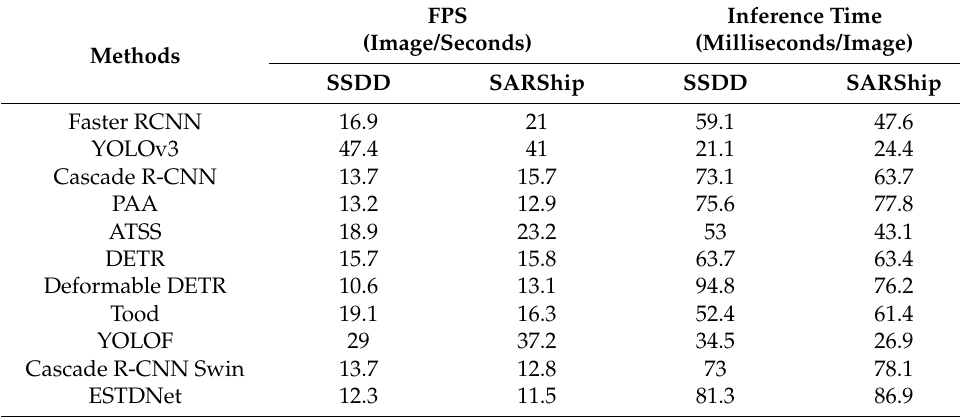
Table 7. Comparison of methods inference